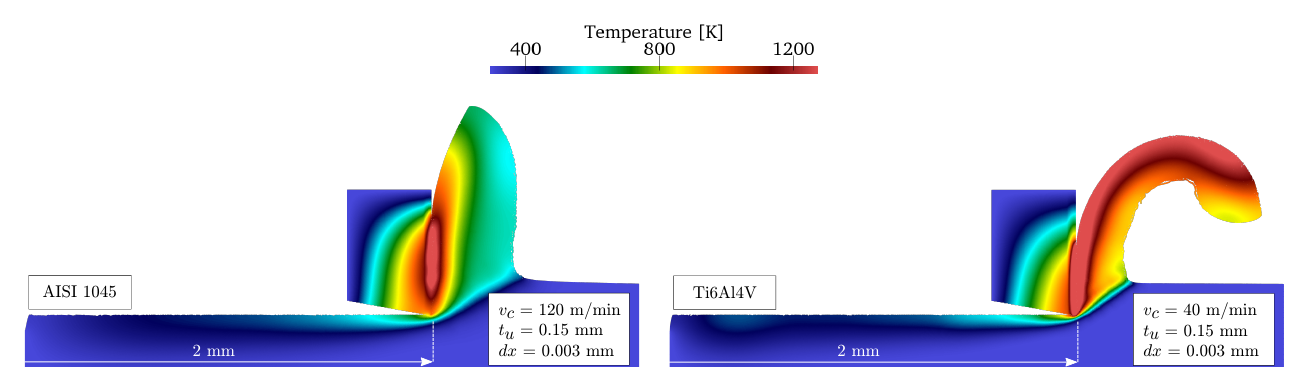
Figure 8. Temperature distribution in high-resolution SPH using µ ( T ) . For better visibility, the color-bar limits are set to 293 and 1273